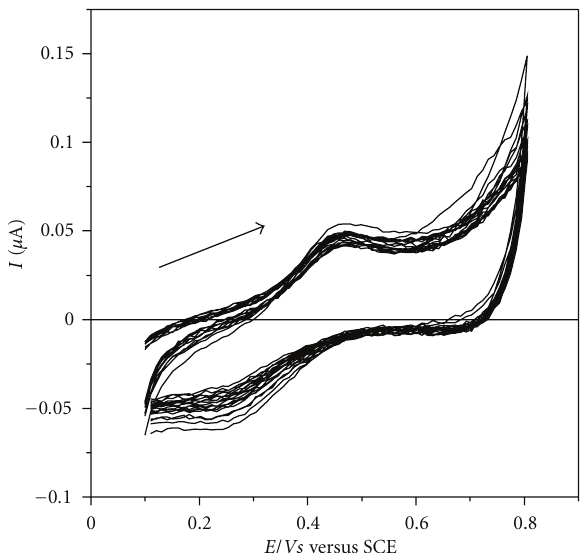
Figure 8: Ascorbic acid detection test: cyclic voltammograms for ITO/(DS 01/NiTsPc) 3 film after successive additions of stock solu- tion containing AA aliquots, in concentrations ranging from 1.235 × 10 − 5 to 20.000 × 10 − 5 molL − 1 . Electrolyte solution H 0.05mol L − 1 , at 25 mVs − 1